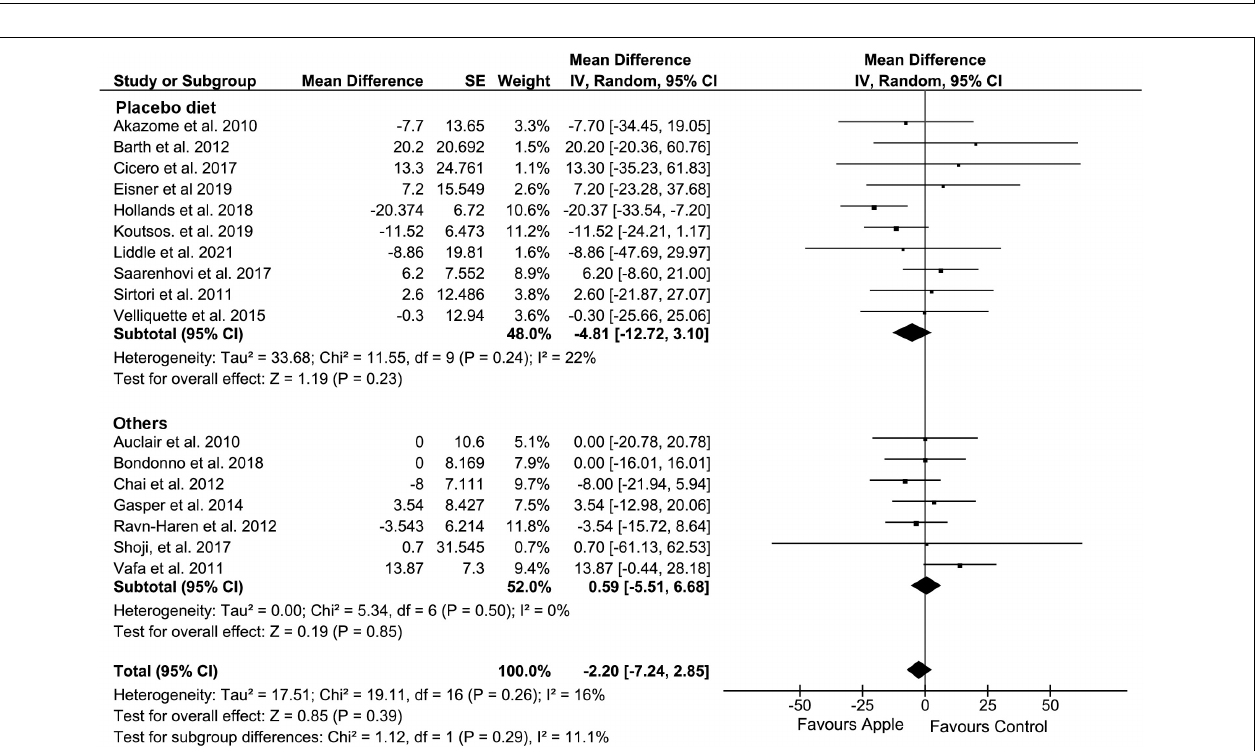
Frontiers in Nutrition |